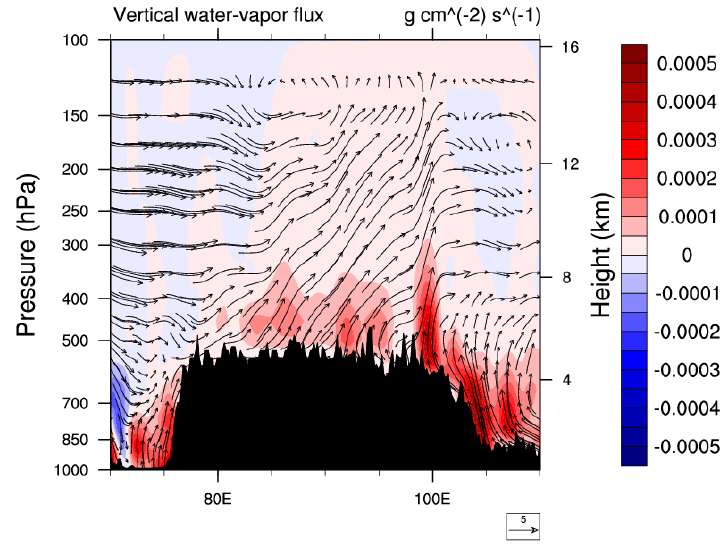
Figure 10. Longitude-pressure section of mean vertical water vapor flux (units: g·cm −2 ·s −1 ) and vertical circulation (vertical velocity and U component of wind) between 31° and 35°N, at 12 UTC on 5 August 2014.